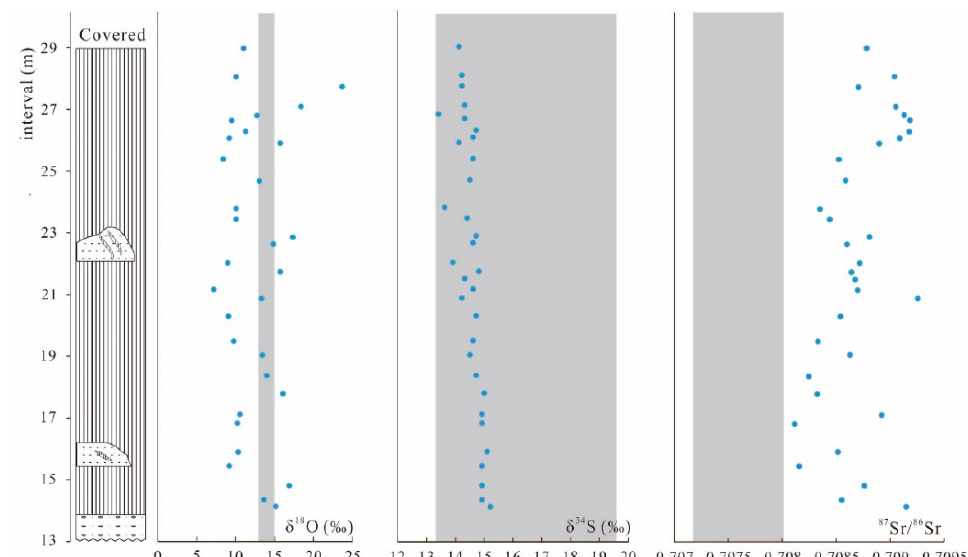
Figure 11. Variations of δ 18 O values, δ 34 S values, and 87 Sr/ 86 Sr ratios of gypsum samples from the section in Baozang. Shaded area: δ 18 O values [19], δ 34 S values [21], and 87 Sr/ 86 Sr ratios [22] of contemporaneous marine sulfates.